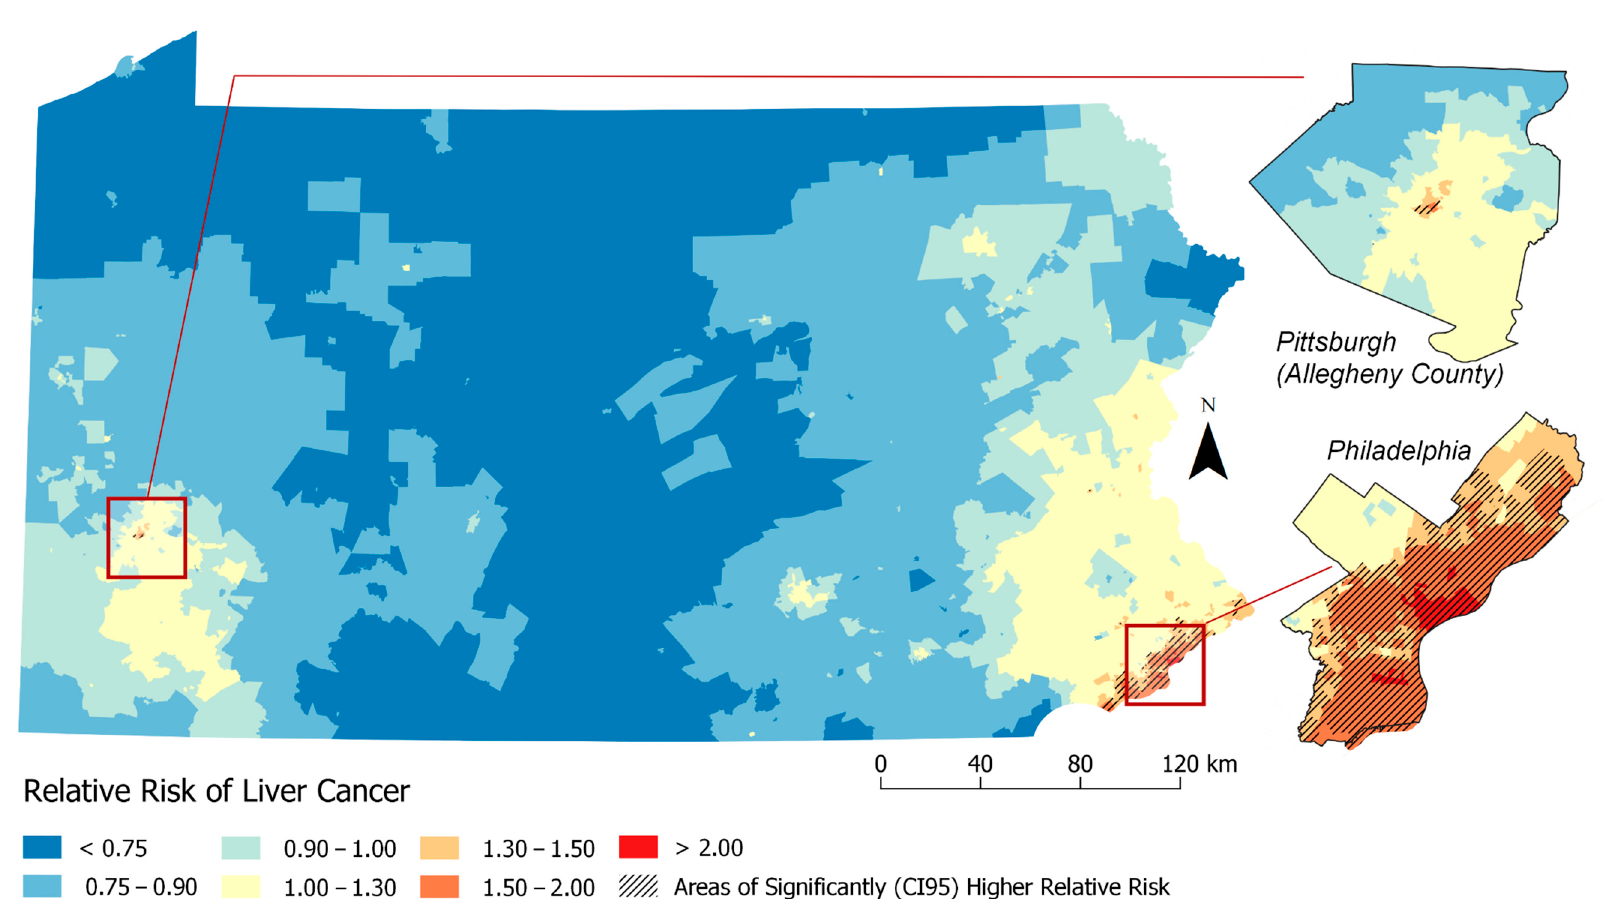
Figure 3. Relative Risk Estimates for Liver Cancer by Census Tract (Model 4. Adjusted for: individual-level factors + previous neighborhood variables (%Non-Hispanic Black (%NHB), Hispanic ICE and Neighborhood Instability) + ICE-Income)